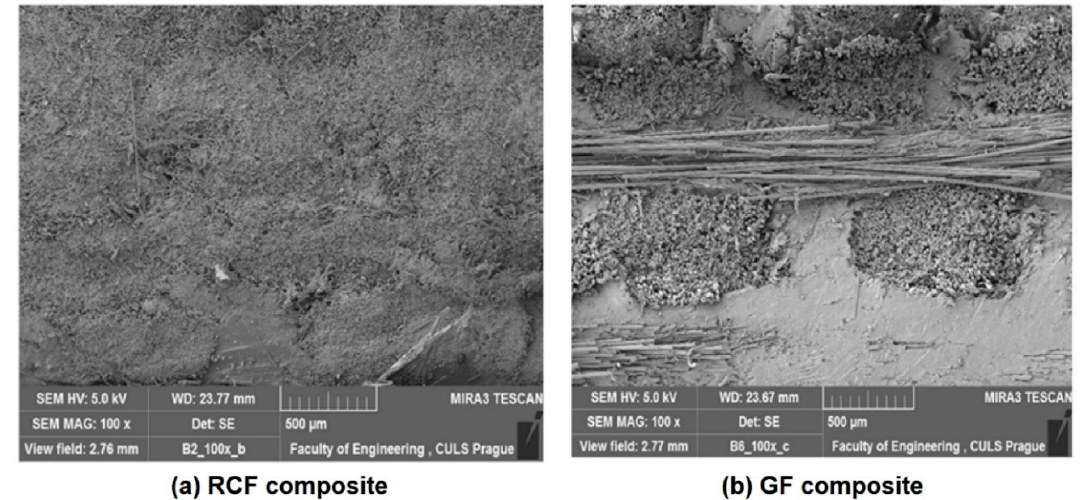
Figure 3. SEM images of cross-sections: ( a ) RCF sample, ( b ) glass fiber sample.